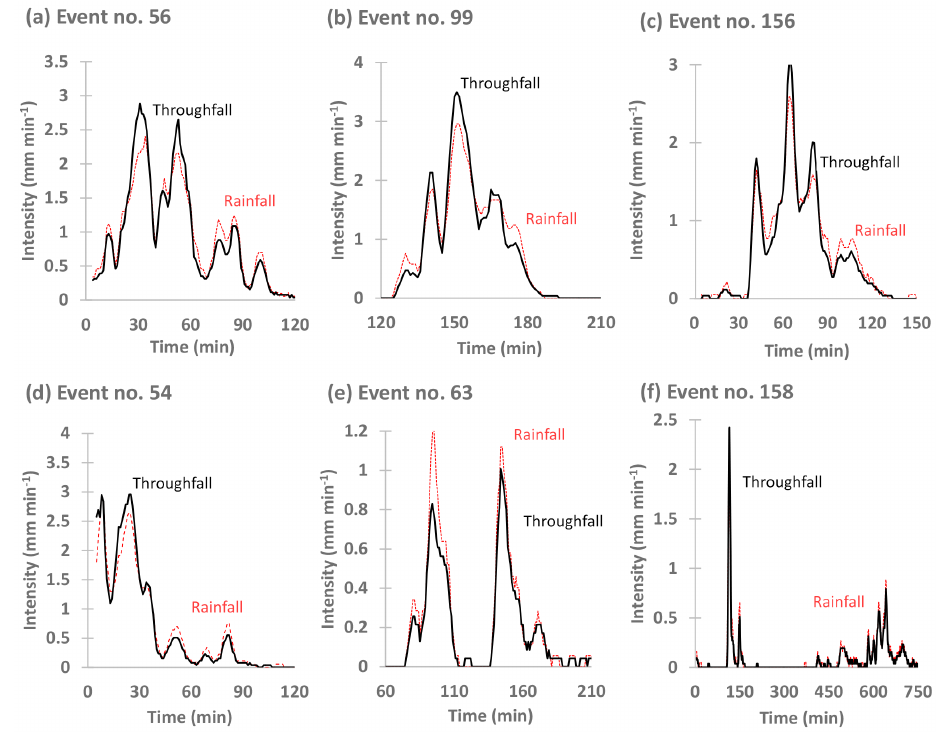
Figure 5. Five-minute running means of throughfall (solid) and rainfall (dashed) for the six largest storms (Table